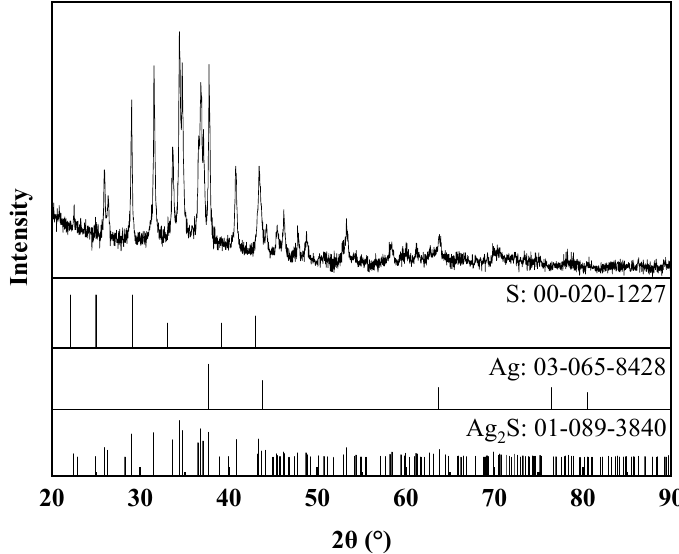
Figure 3. XRD patterns of photoproducts ([Ag] = 500 mg/L, [S 2 O 32 − ] = 0.1 mol/L, 298 K, uncontrolled pH).